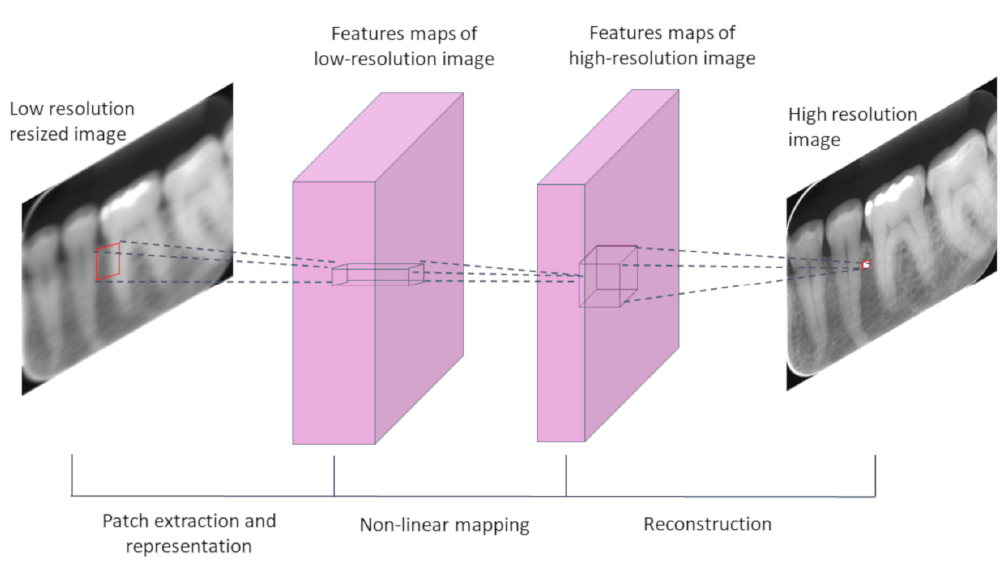
Figure 2. Scheme of the super-resolution convolutional neural network’s (SRCNN) main structure. SRCNNs have been used in several resolution improvement tasks. Umehara, Ota, and Ishida [25] proposed a scheme for resolution improvement in chest CT images based on the SRCNN. The method proposed by Qiu et al. [41] is an SRCNN-based